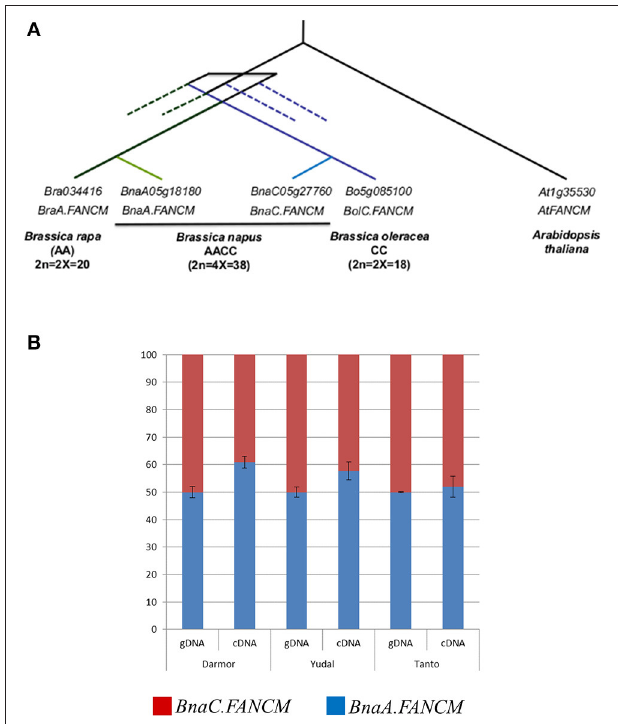
FIGURE 1 | One copy of FANCM per genome is present and expressed in Brassica napus. (A) Schematic representation of the relationships between FANCM homologs in Brassica rapa , B. napus , B. oleracea, and Arabidopsis thaliana . Dotted lines represent the fractionated copies; i.e., copies originating from the Brassica specific whole genome triplication (WGT) and subsequently lost. (B) Relative contribution of BnaA.FANCM and BnaC.FANCM to total expression of FANCM in Brassica napus. Pyrosequencing data for BnaA.FANCM (blue) and BnaC.FANCM (red) in three varieties of B. napus . Genomic DNA (gDNA) was used as a control for biased PCR amplification between the two copies. Error bars = 1 SD from 3 biological